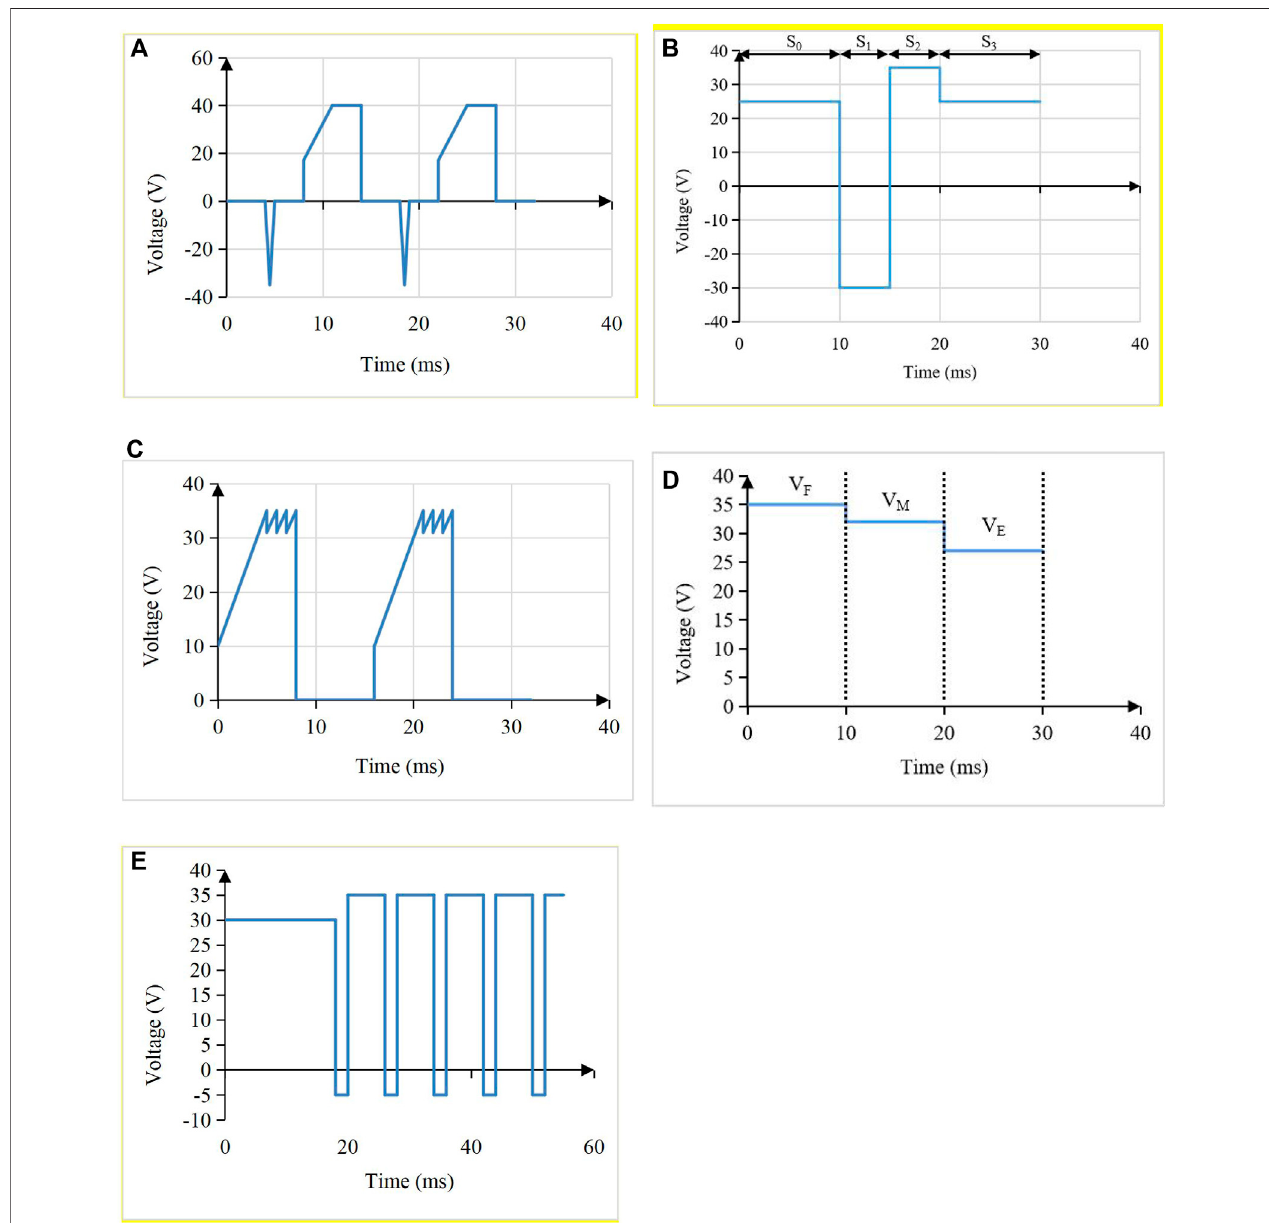
FIGURE 2 | Different driving waveforms. (A) The multi structural driving waveform was designed to increase aperture ratio. (B) Driving waveform with a rising gradient and a sawtooth wave was designed to reduce power consumption. (C) The driving waveform with a reset signal. The reset signal consisted of S 1 and S 2 . The driving signal S 0 was a DC signal. The DC signal was used to drive the EWD to the target gray scale. (D) Amplitude-frequency mixed modulation driving waveform was designedtoreduceresponsetime. (E) TheDCandACmixedwaveform.TheDCdrivingstagewasusedtodrivetheEWDtothetargetgrayscaleandtheACdriving stage was used to prevent oil back fl